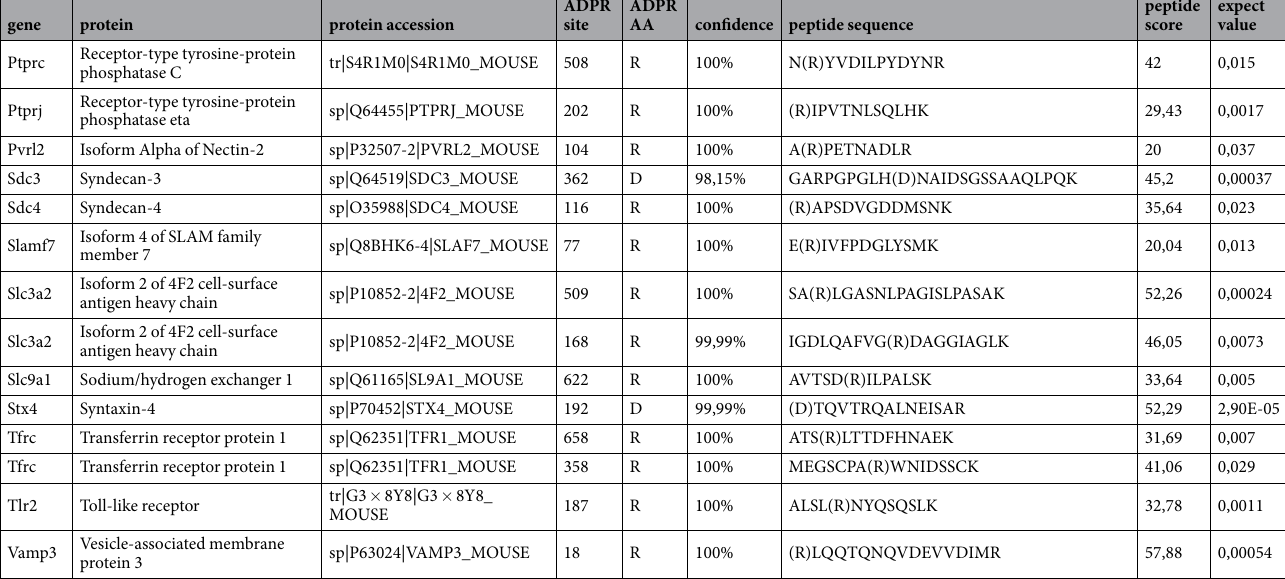
Table 1. List of ADP-ribosylated peptides identified from LPS/U0126 stimulated microglia. Mixed glial cells were stimulated with LPS (0.1 µ g/ml) and U0126 (10 µ M) overnight in BME medium containing 10% FCS. CD11b + microglia were FACS sorted, incubated with 50 µ M NAD and 2.5 mM DTT for 30 min on ice, washed twice with PBS and lysed using RIPA buffer. After trypsin digestion ADPR peptides were enriched using macrodomain Af1521 and samples were subjected to mass spectrometry analyses. Only peptides of cell surface proteins displaying a peptide score > 20 and a confidence of > 95% were included into the